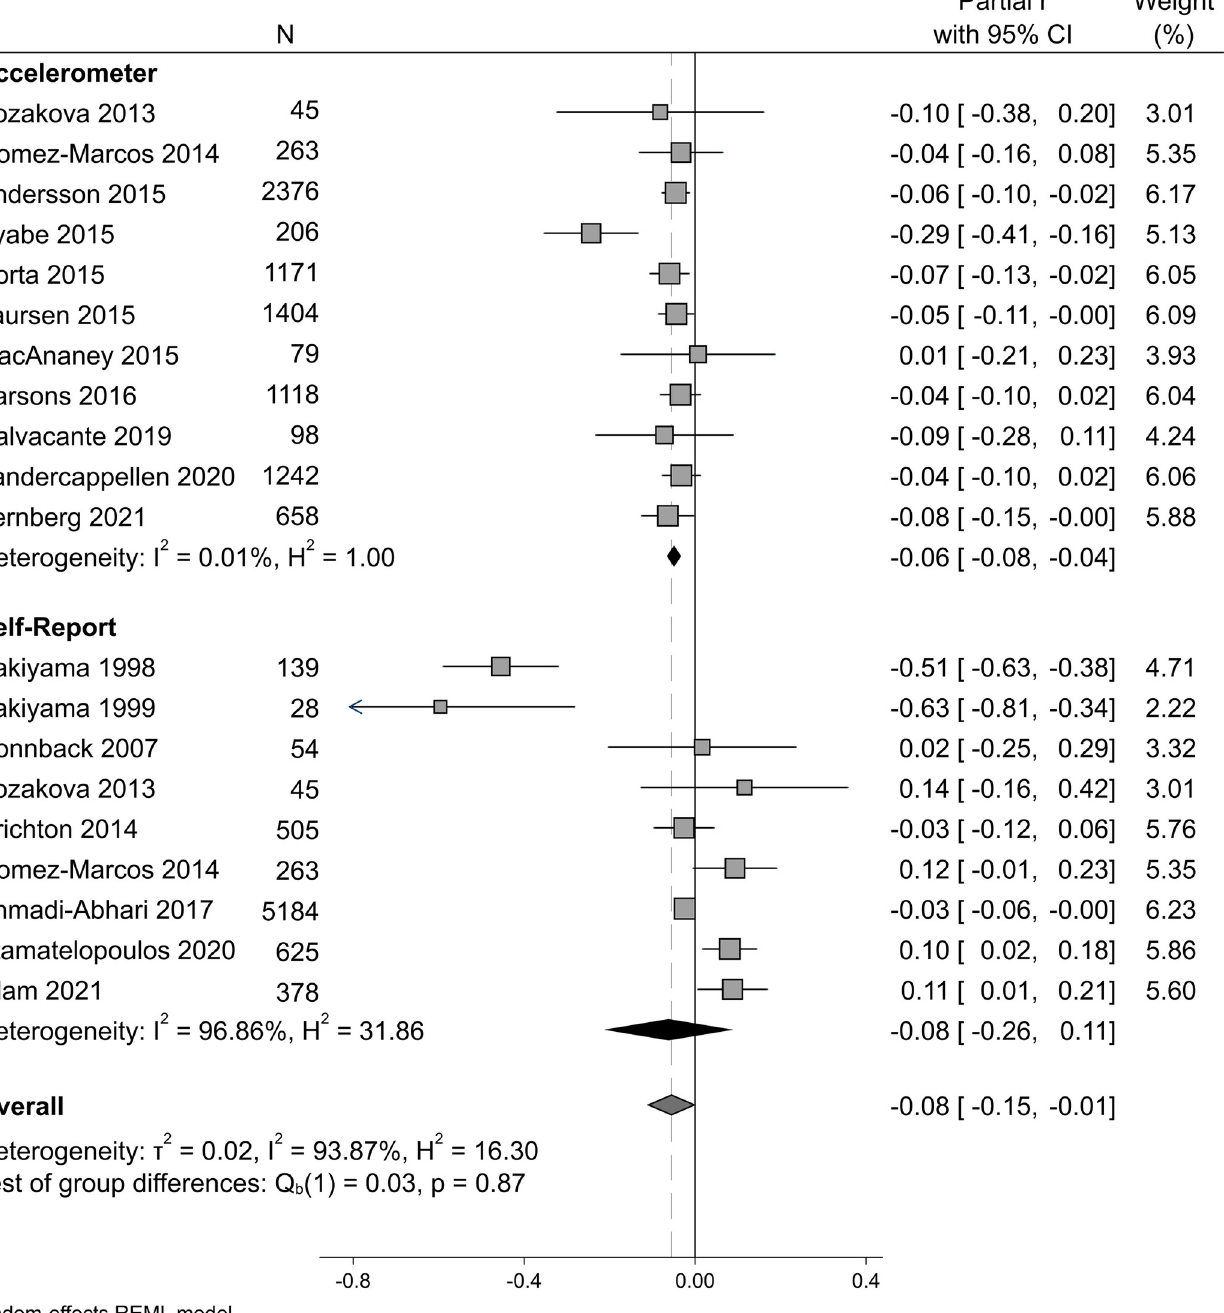
PLOS ONE | https://doi.org/10.1371/journal.pone.0284164 April 6,